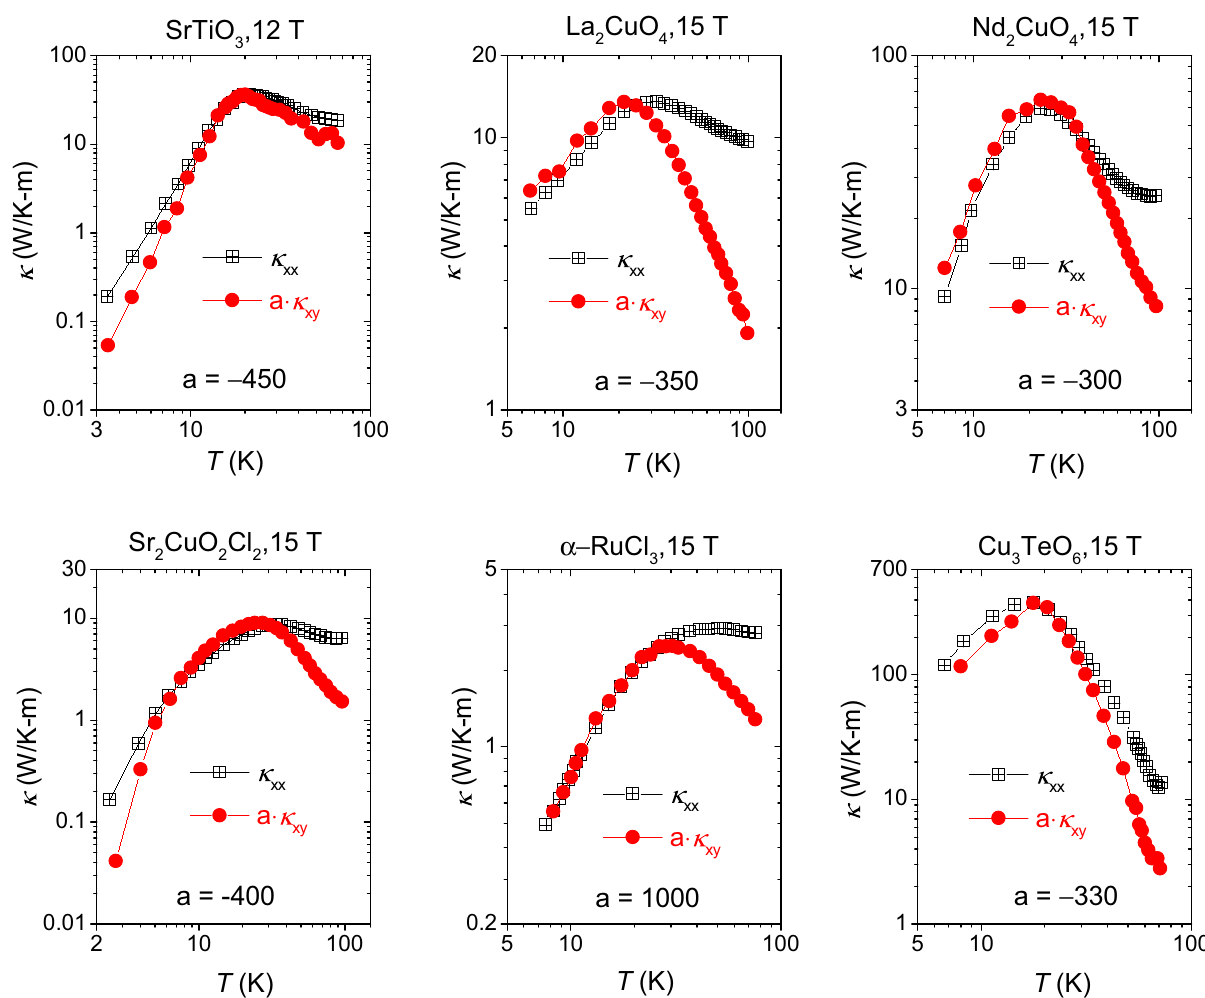
Fig.3|Peaksin κ ij ( T )andin κ ii ( T ). Comparisonof κ ij ( T )with κ ii ( T )insixdifferentinsulatingmaterials:SrTiO 3 7 ,La 2 CuO 4 6 ,Nd 2 CuO 4 6 ,Sr 2 CuO 2 Cl 2 6 α -RuCl 3 13 andCu 3 TeO 6 9 .In each case, κ ij ( T ) is multiplied by an ampli fi cation factor a varying from ( − )300 to ( −